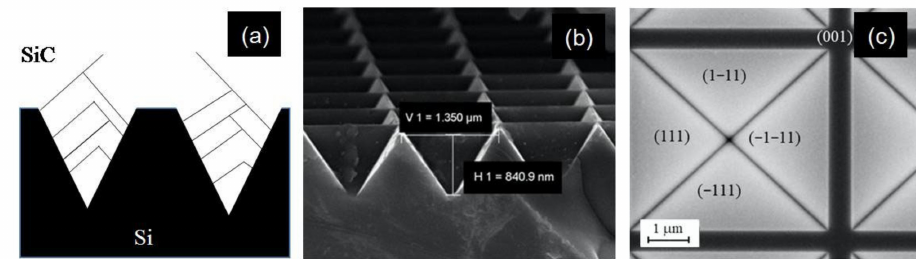
Figure 8. ( a ) Schematic cross-section view of the effect of the ISP compliant substrate on the SFs. Silicon and silicon carbide are drawn as black and white regions. Blue lines are SFs. ( b ) Cross-view SEM image of the ISP structure. ( c ) Plane-view SEM image. The four (111) planes of the pyramid are shown, as well as the (001) region among the two pyramids (adapted from Reference [17]).